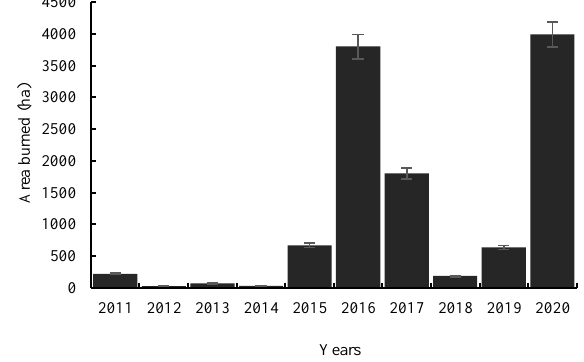
Figure 3: The area of fires occurred from 2011 to 2020 The highest number of fires, the uppermost occurrence of fires on Nawdar, Ghalajeh-Cheleh, and Poshteh-Melineh areas, with 28, 27 and 26 fires, respectively, throughout 2011-2020 (Figure 4).